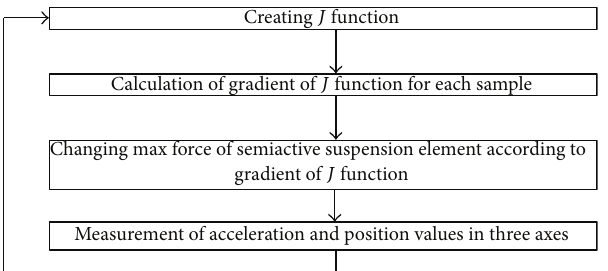
Figure 2: Flowchart of control